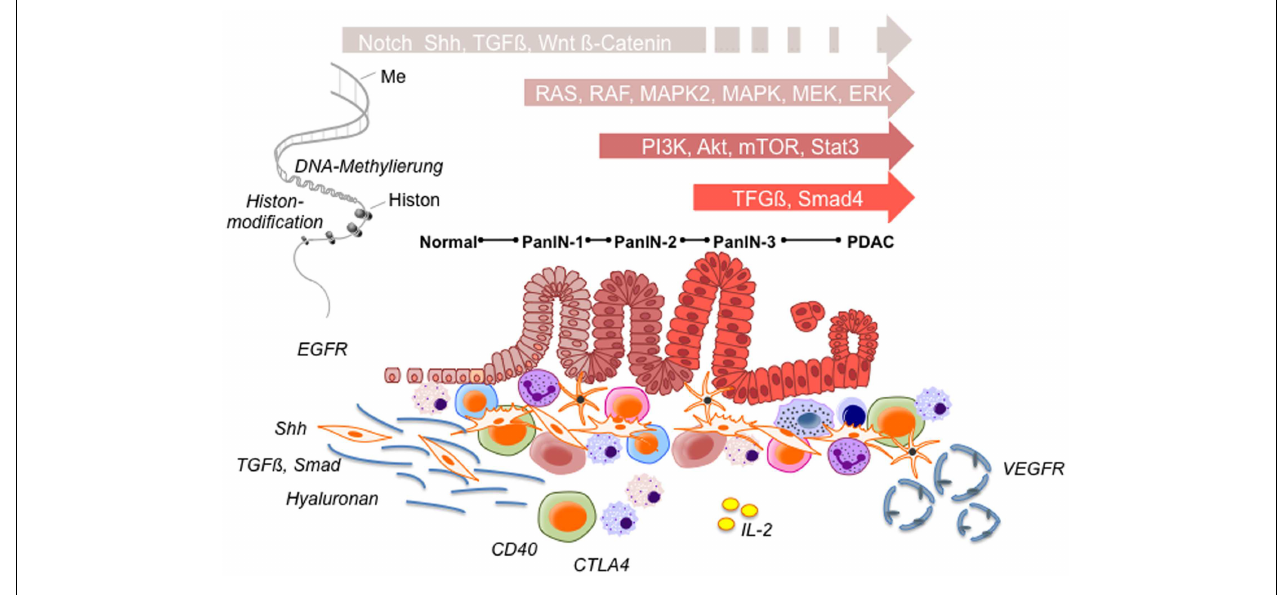
stromal response. According to significantly involved signaling pathways tumor cell survival, angiogenesis, invasion, desmoplasia, and tumor immune response are affected, respectively. Ensuing alterations together with epigenetic changes are strongly involved in promoting tumor progression and chemotherapy resistance, and thus provide potential therapeutic targets in pancreatic